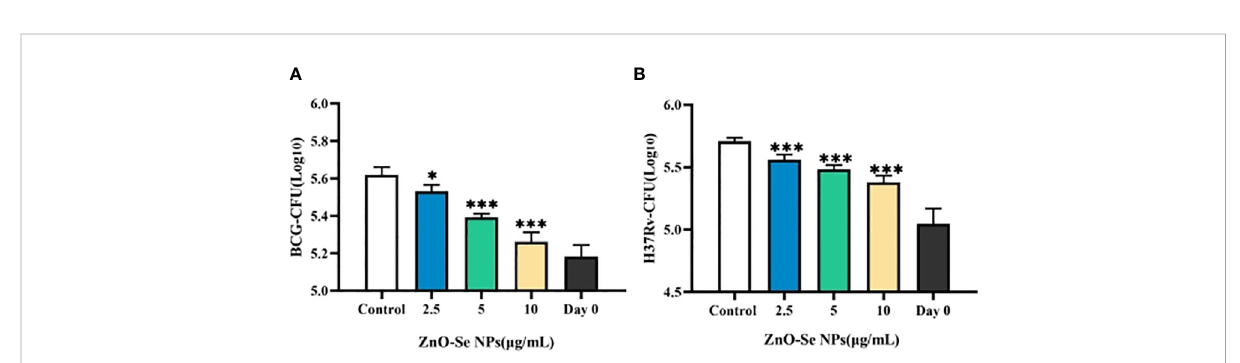
FIGURE 7 Inhibition effects of ZnO-Se NPs on the intracellular Mtb. (A) Effects of ZnO-Se NPs on BCG growth in BCG infected THP-1 cells, *p<0.05, ***p<0.001. (B) Effects of ZnO-Se NPs on H37Rv growth in H37Rv infected THP-1 cells, *p<0.05,